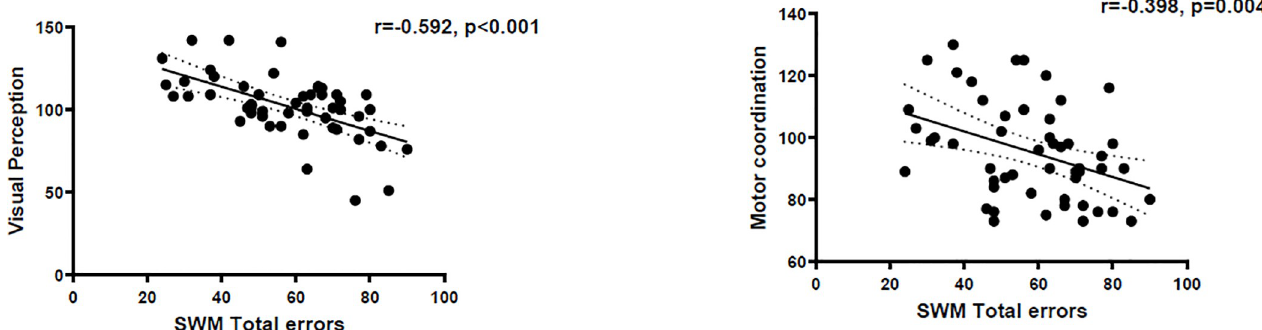
Fig 1. Correlations between Spatial Working Memory and VMI performances in children with ASD. The Pearson correlation analyses were conducted with age and IQ as covariant. The left picture showed a correlation between spatial working memory and visual perception (r = -0.592, p < 0.001); The right figure indicated a correlation between spatial working memory and motion coordination (r = -0.398, p = 0.004).